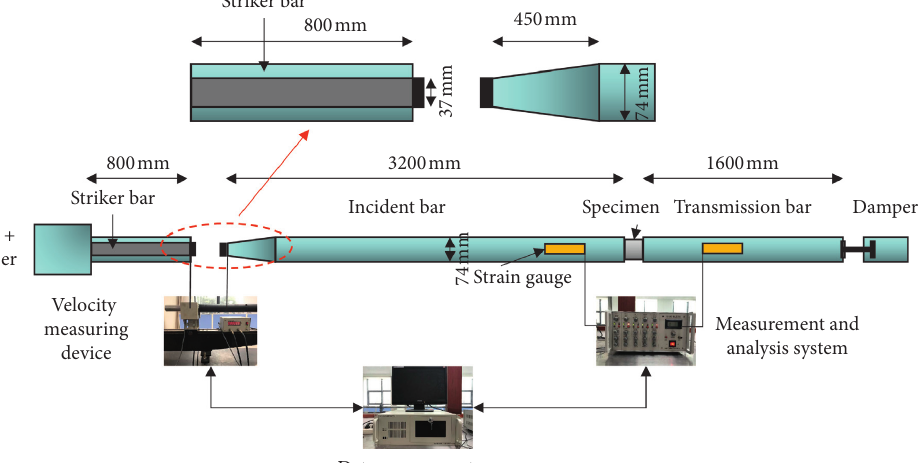
Figure 3: Schematic illustration of the SHPB apparatus.